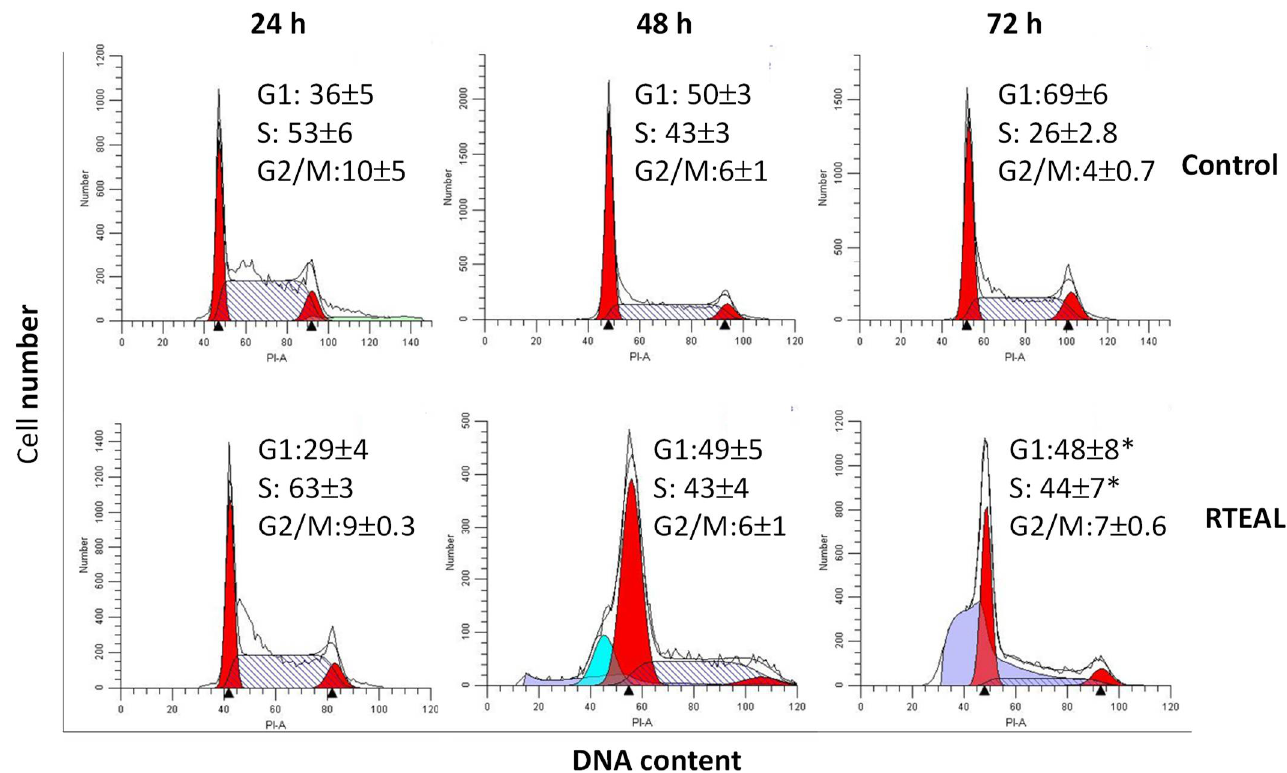
Figure 7. Time-dependent alteration in the cell cycle progression. MCF-7 cells were treated with 28 µg/mL of RTEAL for 24, 48 and 72 h. Data were presented as mean ± SEM of the three independent experiments. Asterisks indicate a significant difference (* p < 0.05) for each treatment was compared to the control cells.